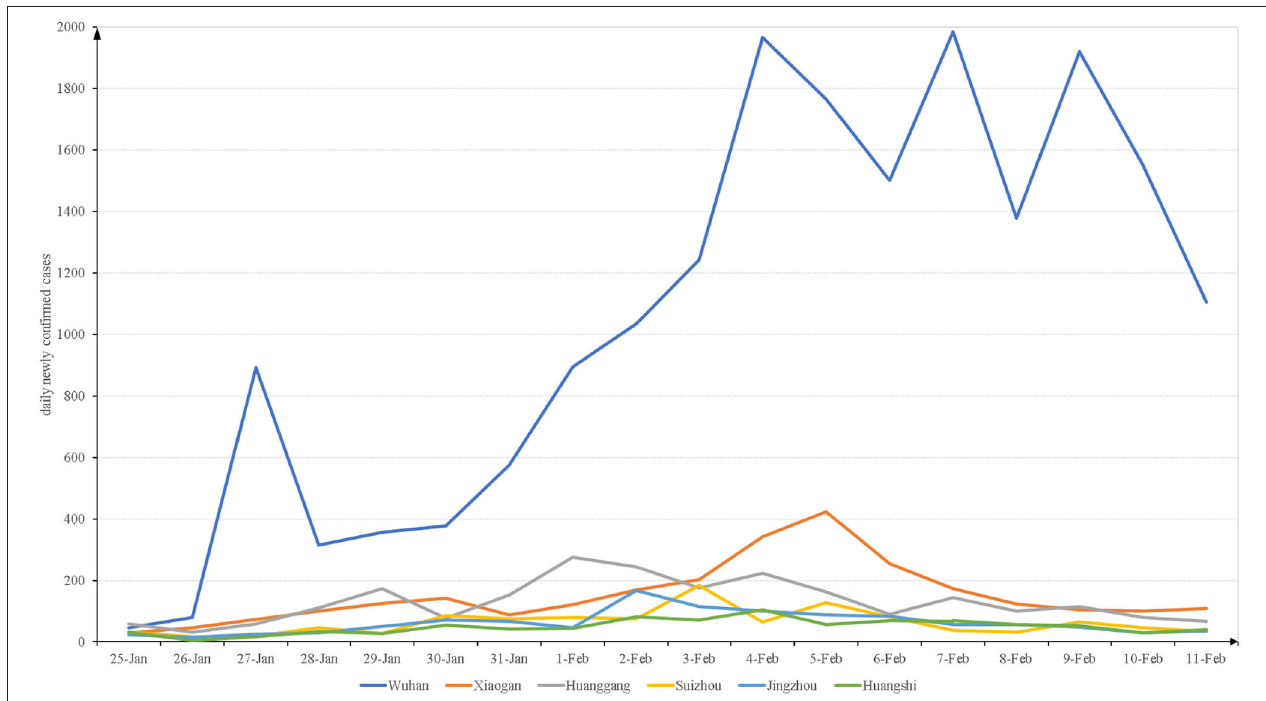
FIGURE 1 | The daily newly confirmed cases from 2020-1-25 to 2020-2-11 in Hubei.